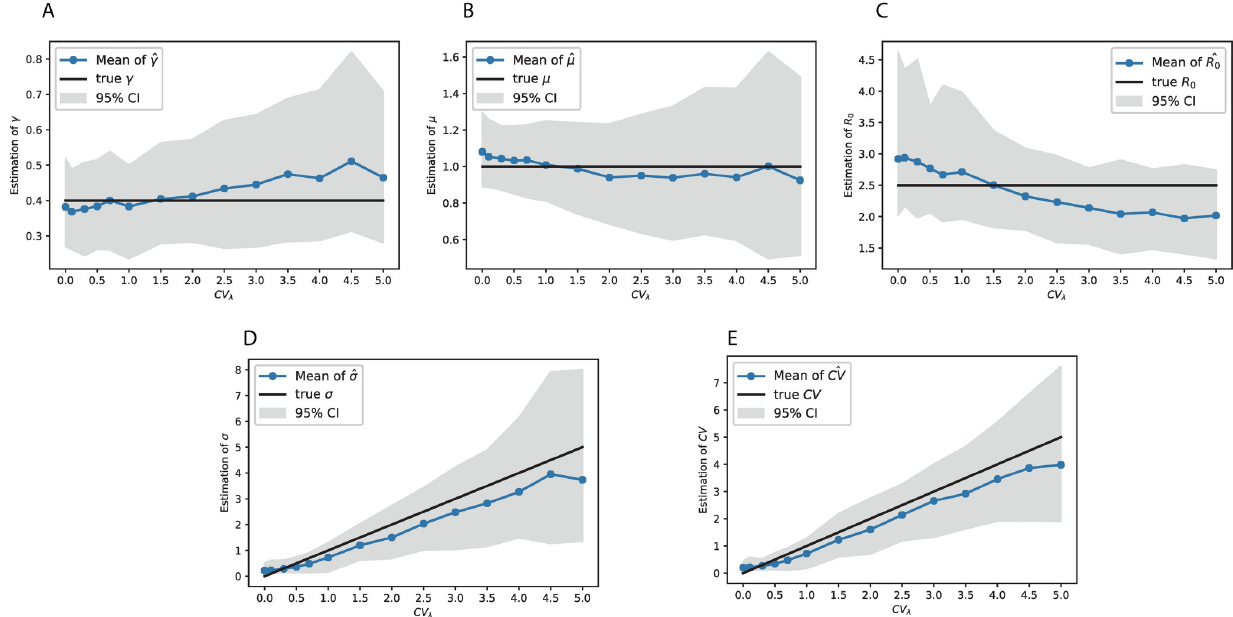
Fig 3. Estimates of the heterogeneity and other epidemiological parameters from simulated virus genealogy. The simulations were performed under various true levels of heterogeneity ( CV ¼ s = m ). In each panel, the black line denotes the true value that was used to generate the simulated data, and the l l l colored curve and the shaded area denote the mean and 95% confidence interval from 200 simulations, respectively. A estimate of recovery rate ( γ ), B estimate of average infectivity rate ( μ λ ), C estimate of the basic reproduction number ( R 0 ), D estimate of the standard deviation of infectivity rate ( σ λ ), and E estimate of the coefficient of variation ( CV λ